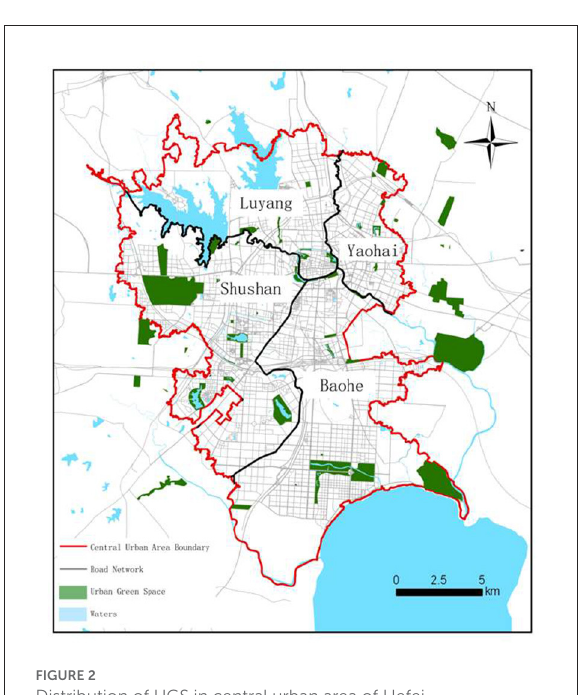
FIGURE2 Distribution of UGS in central urban area of